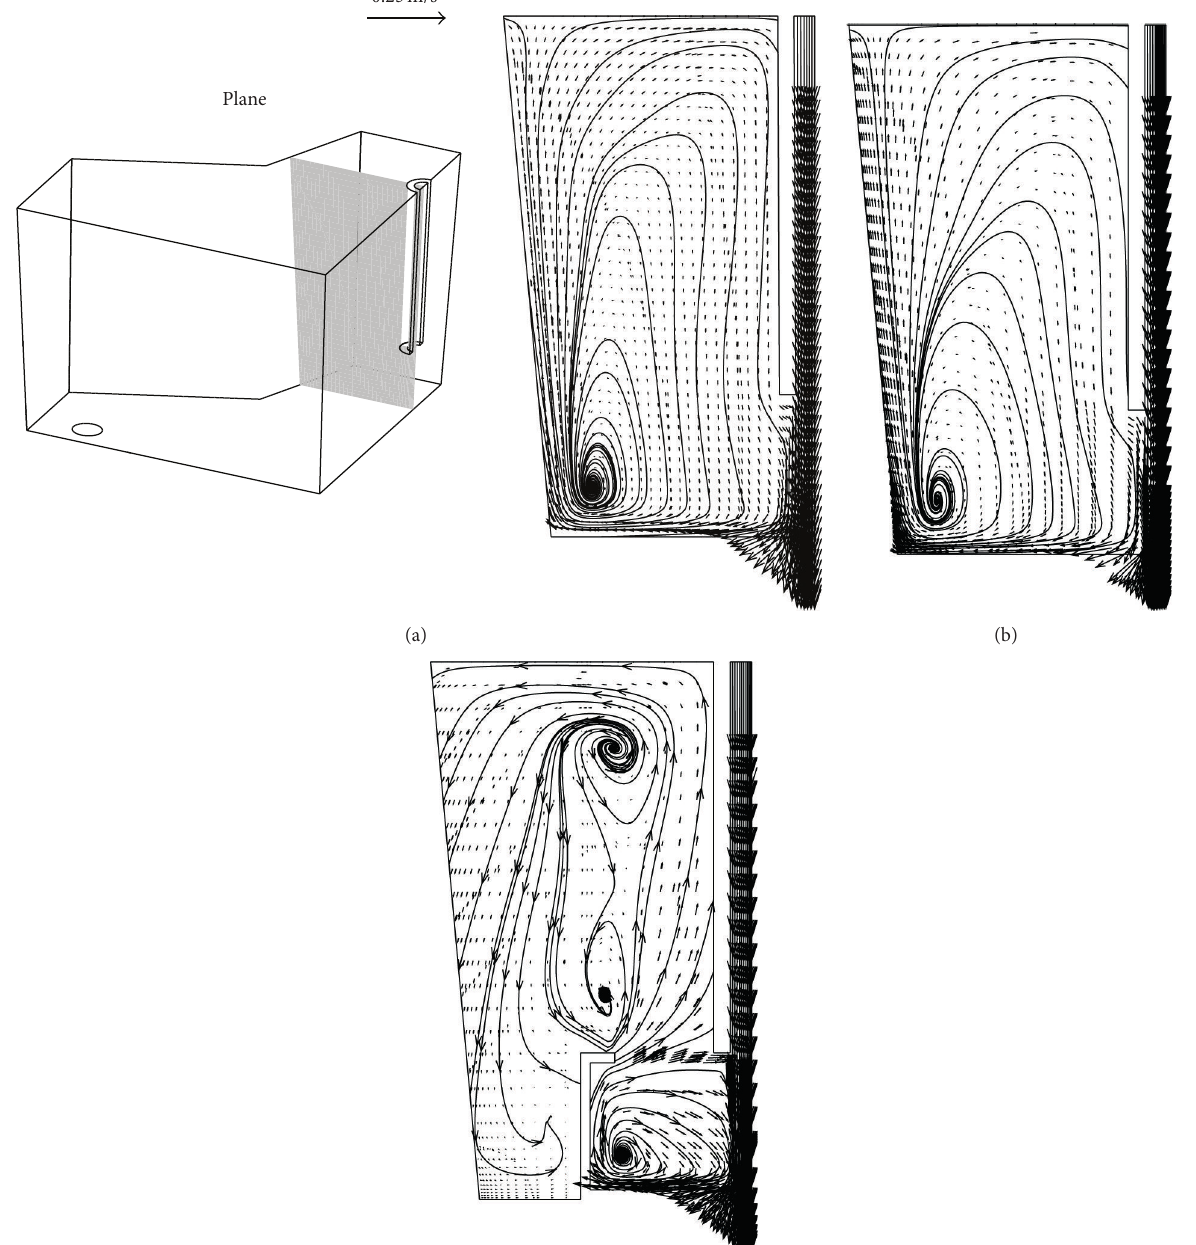
Figure 8: Predicted metal flow field in tundish for all cases: (a) Case I, (b) Case II, and (c) Case